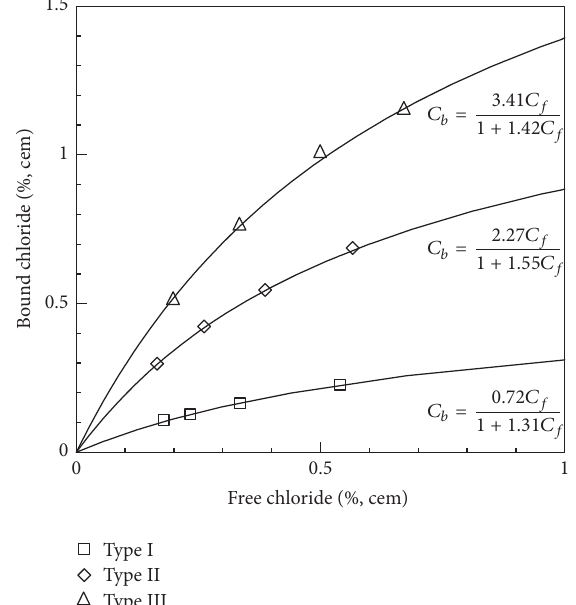
Figure 4: Relation between free and bound chlorides at a given total chloride concentration in cement mortar with different HAC types after 100 days of exposure to 1.0M NaCl solution (expressed by the Langmuir isotherm).